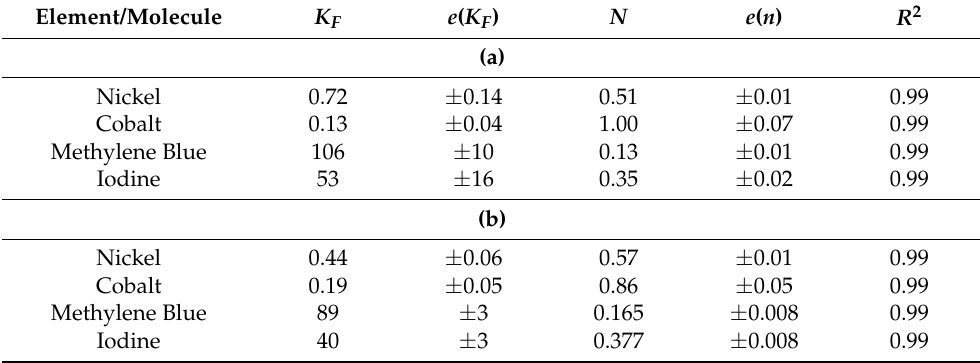
Table 6. Parameter results from nonlinear fitting between q e and C e using Freundlich model ( a ); and parameter results from linear fitting between log( q e ) and log( C e ) using Freundlich model ( b ).